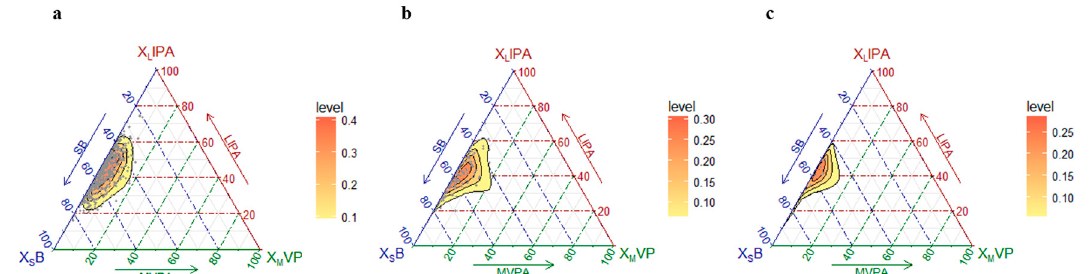
Figure 1. Ternary plots of the sample compositions of time spent in sedentary behavior (SB), light intensity physical activity (LPA) and moderate-to-vigorous intensity physical activity (MVPA) for the robust ( a ), pre-frail ( b ) and frail ( c ) subgroups.